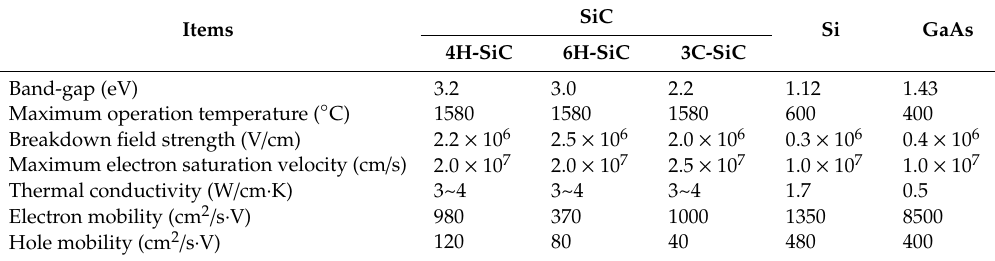
Table 2. The physical properties of the available semiconductor materials under room temperature (25 ◦ C).